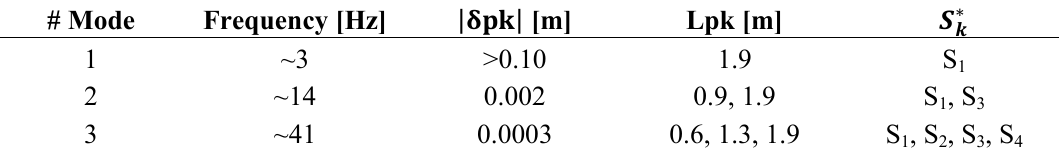
Table 2. Characteristics and parameters associated to the first three vibration